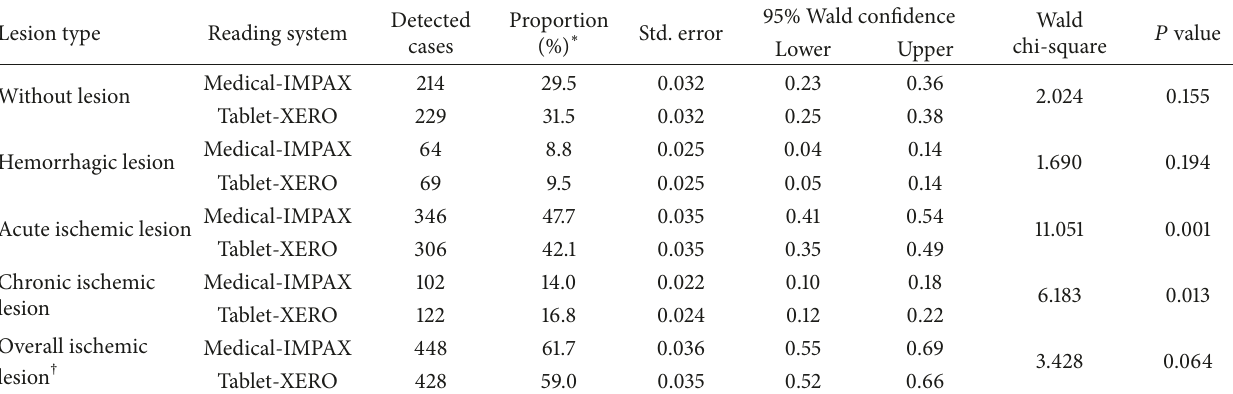
Table 1: Comparison of the distribution of the type of stroke classification between the reading systems.